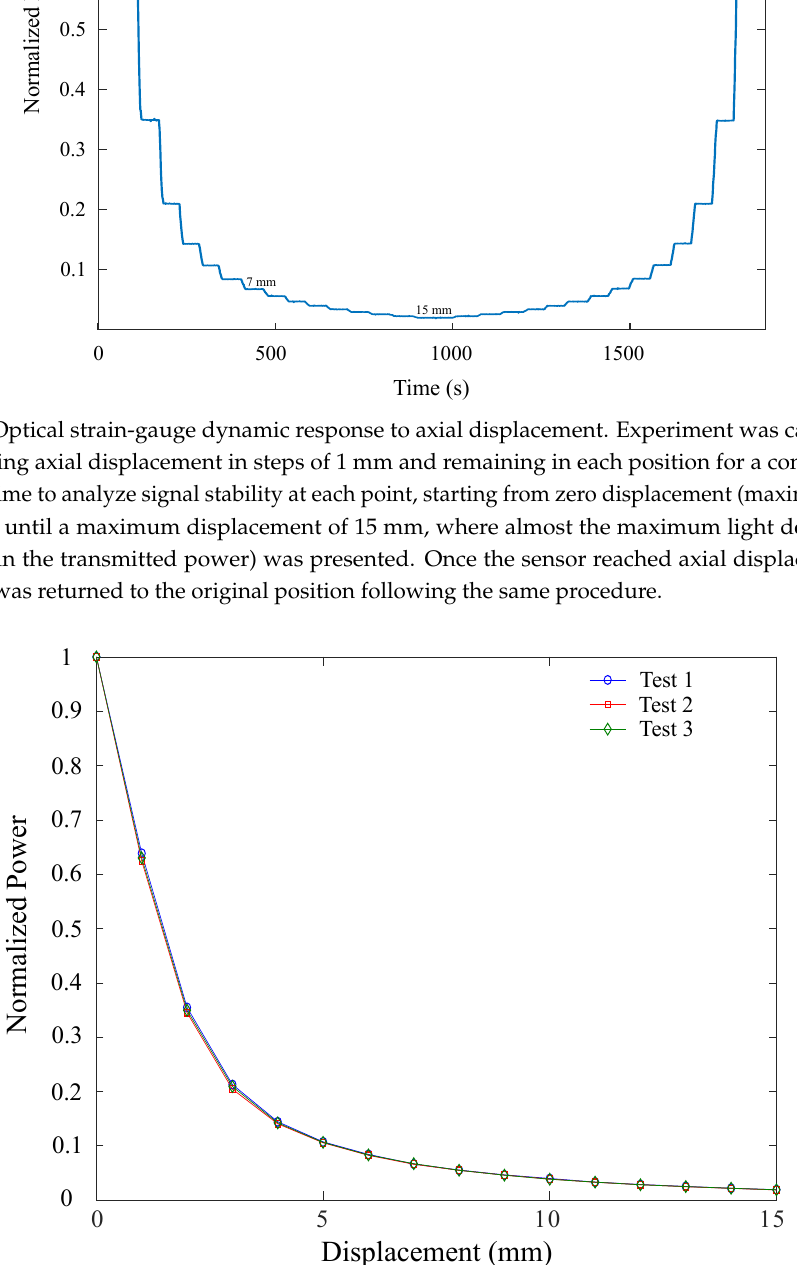
Figure 8. Optical strain-gauge response. Normalized power attenuation in function of axial displacement (mm) is illustrated for three different